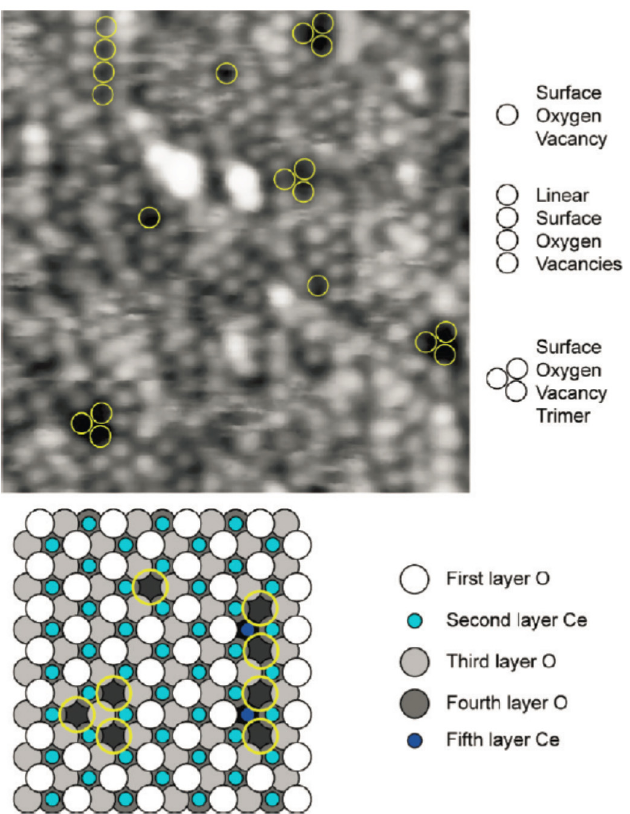
Figure 4. Atomically resolved, filled state, STM image, and structural model depicting surface oxygen vacancies on an ultrathin film of CeO 2 on Pt(111). Bright spots correspond to top-layer oxygen termination of the surface, and surface vacancies are observed as isolated individuals, trimers, and linear arrangements, as highlighted by yellow circles superimposed on the STM image. Reprinted with permission from Grinter et al. [17]. Copyright ACS 2010.